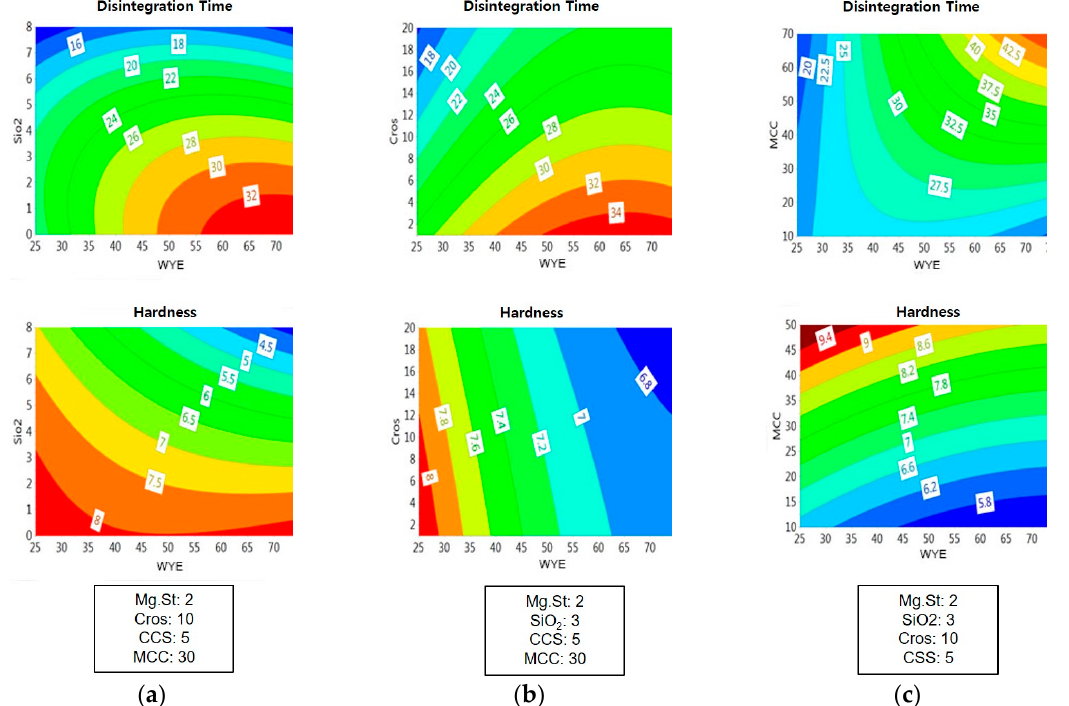
Figure 6. Contour plots depicting the effects of ( a ) silicon dioxide (SiO 2 ) vs. Wuzi Yanzong dry extract (WYE); ( b ) Crospovidone (Cros) vs. Wuzi Yanzong dry extract (WYE); and ( c ) microcrystalline cellulose (MCC) vs. Wuzi Yanzong dry extract (WYE) on disintegration time (top) and hardness (bottom).